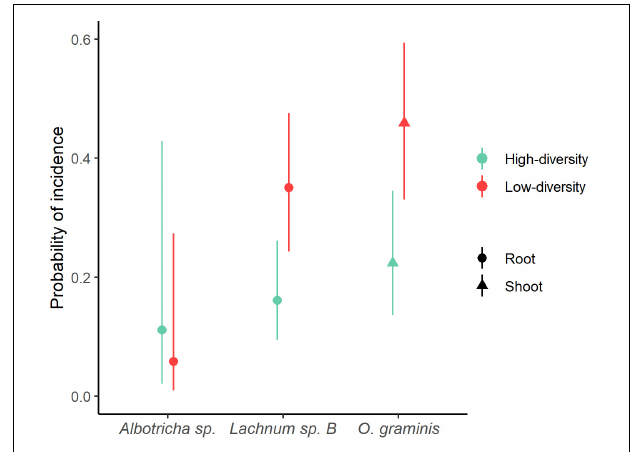
FIGURE 6 | Probability of incidence of fungal indicator species of Brachypodium rupestre calculated with